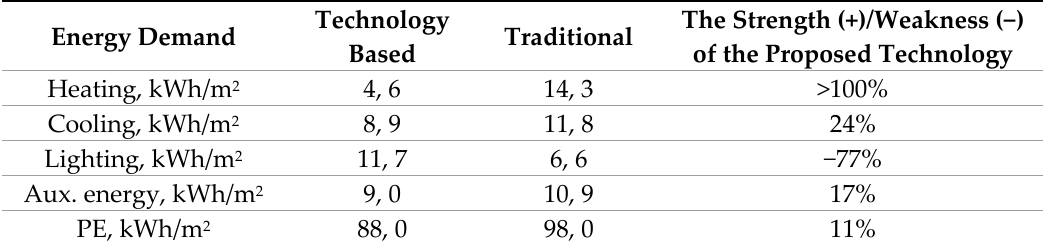
Table 1. The parameters of buildings energy